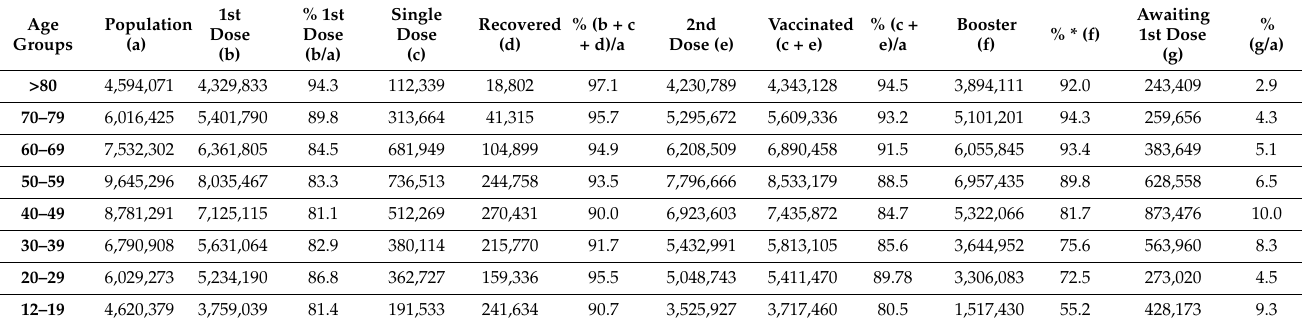
Number and percentages of COVID-19 vaccination by age groups in Italy up to 11 February 2022. Source: Authors’ elaboration from Presidenza del Consiglio dei Ministri (Office of the Prime Minister) report